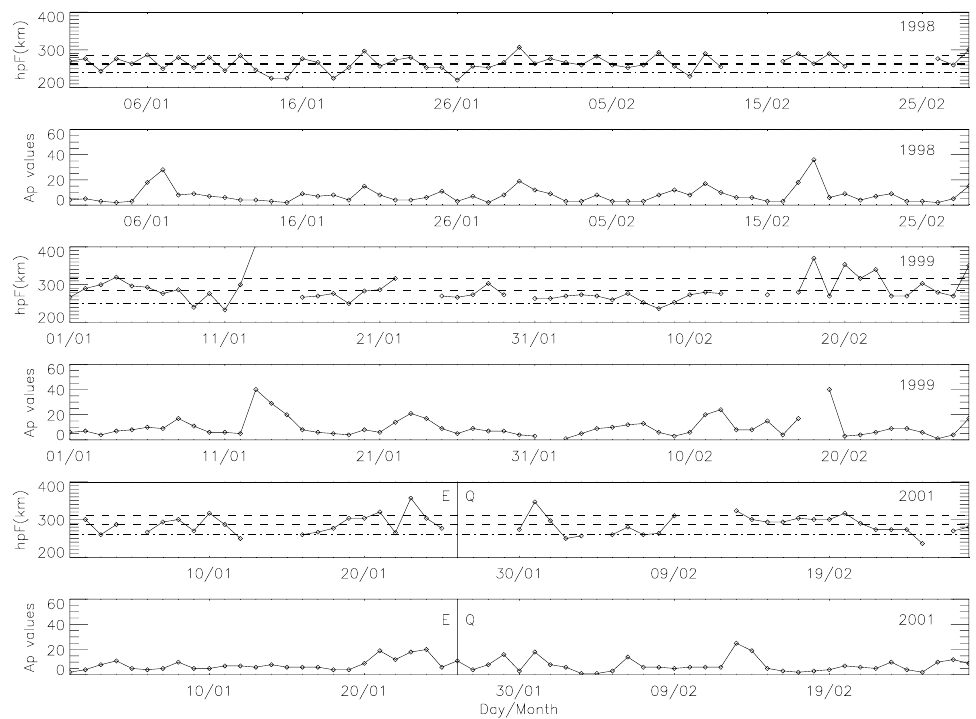
Fig. 10. Variations of an average h p F2 value taken between 22:00, 23:00, and 24:00UT at the Ahemadabad ionospheric station and variations of the magnetic index A p as a function of the January and February days. From the top to the bottom, the plots are done for the year 1998, 1999, and 2001 (the quake occurred on 26 January